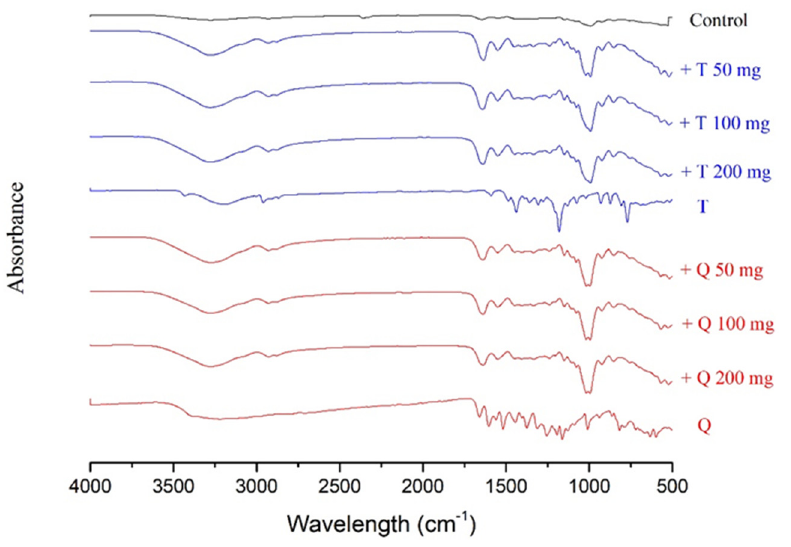
Figure 2. Fourier transform infrared (FT-IR) spectra of the cassava/gelatin films at different concen- trations of quercetin (Q) and TBHQ (T) (without antioxidant serves as control). Table 2. FT-IR peaks wavenumbers of the cassava/gelatin films at different concentrations of quercetin (Q) and TBHQ (T) (without antioxidant serves as